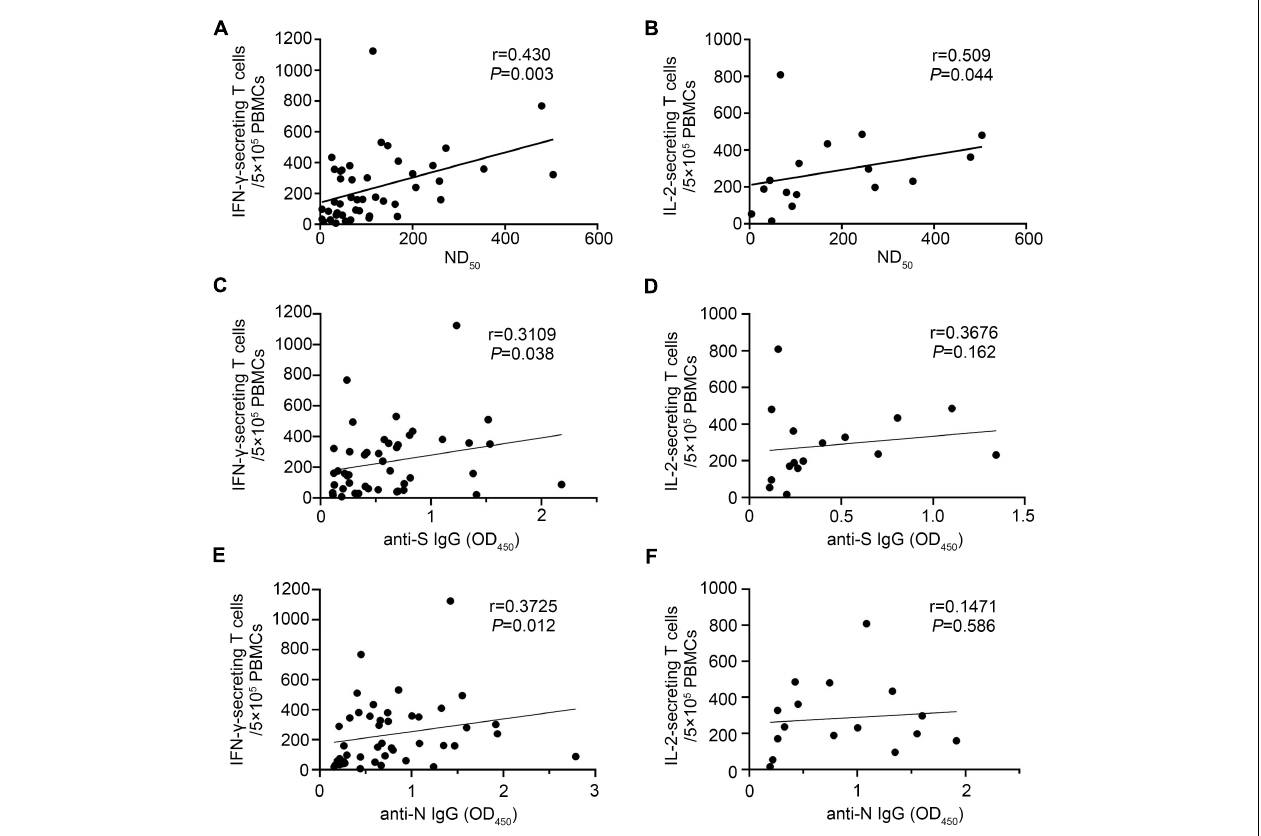
FIGURE 7 | The SARS-CoV-2-specific T-cell response correlated with antibody levels 17–18 months after infection. IFN- γ - and IL-2-secreting T-cell responses and antibody (ND50, anti-S IgG, and anti-N IgG) levels were performed in COVID-19 convalescent patients 17–18 months after illness onset. (A) Correlation of ND 50 and SARS-CoV-2-specific IFN- γ -secreting T cells ( N = 45). (B) Correlation of ND 50 and SARS-CoV-2-specific IL-2-secreting T cells ( N = 16). (C) Correlation of anti-S IgG levels and SARS-CoV-2-specific IFN- γ -secreting T cells ( N = 45). (D) Correlation of anti-S IgG levels and SARS-CoV-2-specific IL-2-secreting T cells ( N = 16). (E) Correlation of anti-N IgG levels and SARS-CoV-2-specific IFN- γ -secreting T cells ( N = 45). (F) Correlation of anti-N IgG levels and SARS-CoV-2-specific IL-2-secreting T cells ( N = 16). A two-sided Spearman rank correlation test was used to evaluate the correlation between SARS-CoV-2-specific T-cell responses and antibody